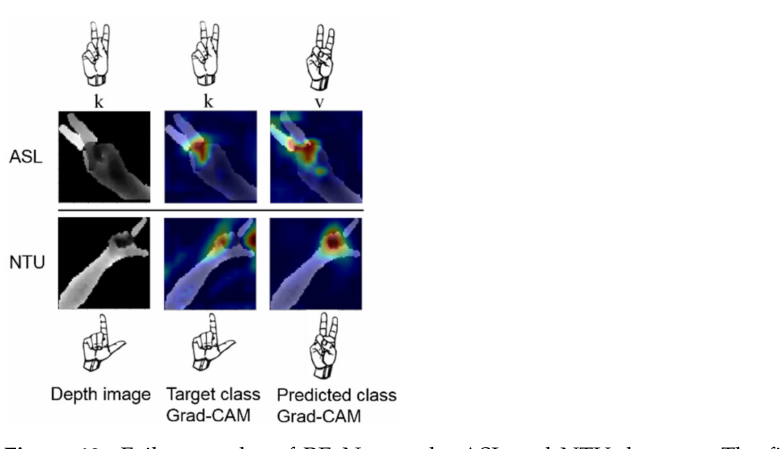
Figure 10. Failure modes of RFaNet on the ASL and NTU datasets. The first and fourth rows represent the labels corresponding to the images and feature maps, respectively. The second and third rows represent the depth images and their Grad-CAM visualizations, respectively, according to their target and predicted